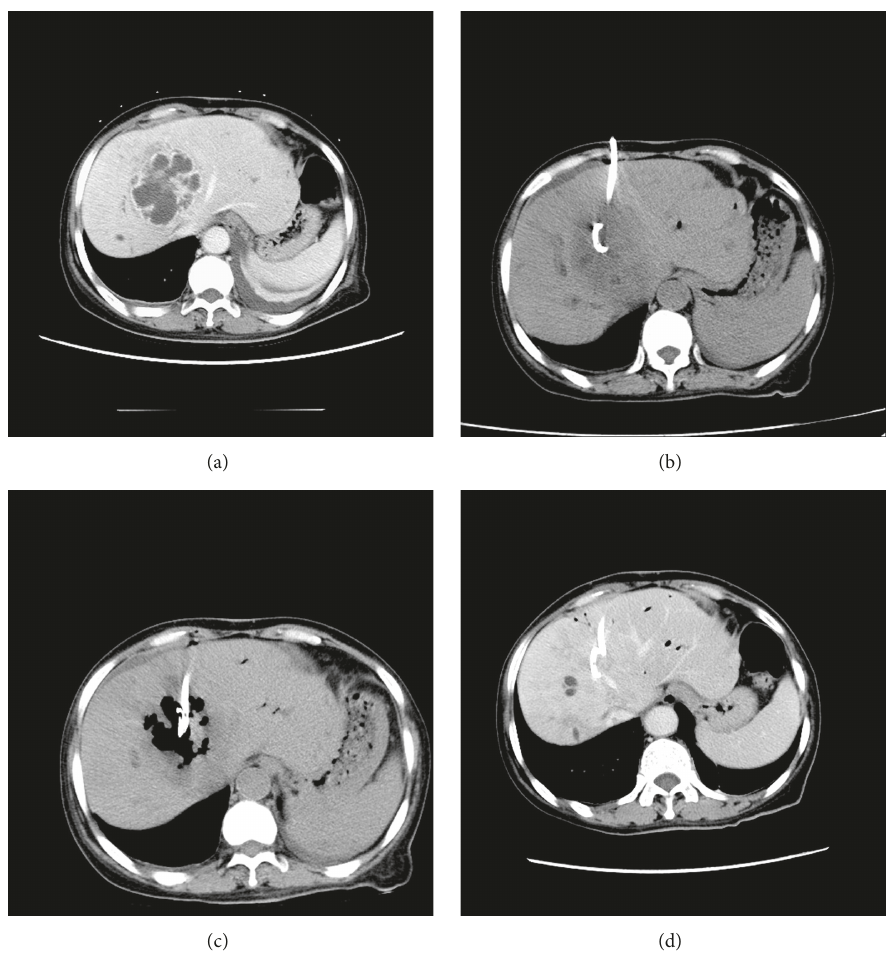
Figure 1: A 49-year-old male presented with fever and right back pain for one week. (a) A lager multiloculated liver abscess in the right hepatic lobes was shown by enhanced CT, and small amount of fluid can be seen in the left chest. (b) Catheter was placed under CT guidance, without injection of oxygen-ozone gas. (c) Three-week follow-up showing that abscess was not fully absorbed. (d) Abscess was fully absorbed after eight